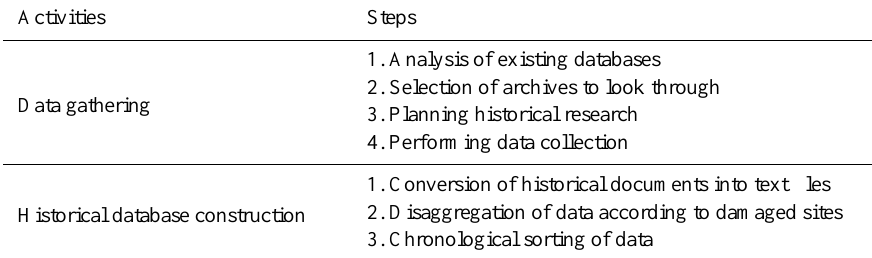
Table 1. Main steps in the creation of the historical database concerning floods (Petrucci and Pasqua, 2008; Polemio and Petrucci,